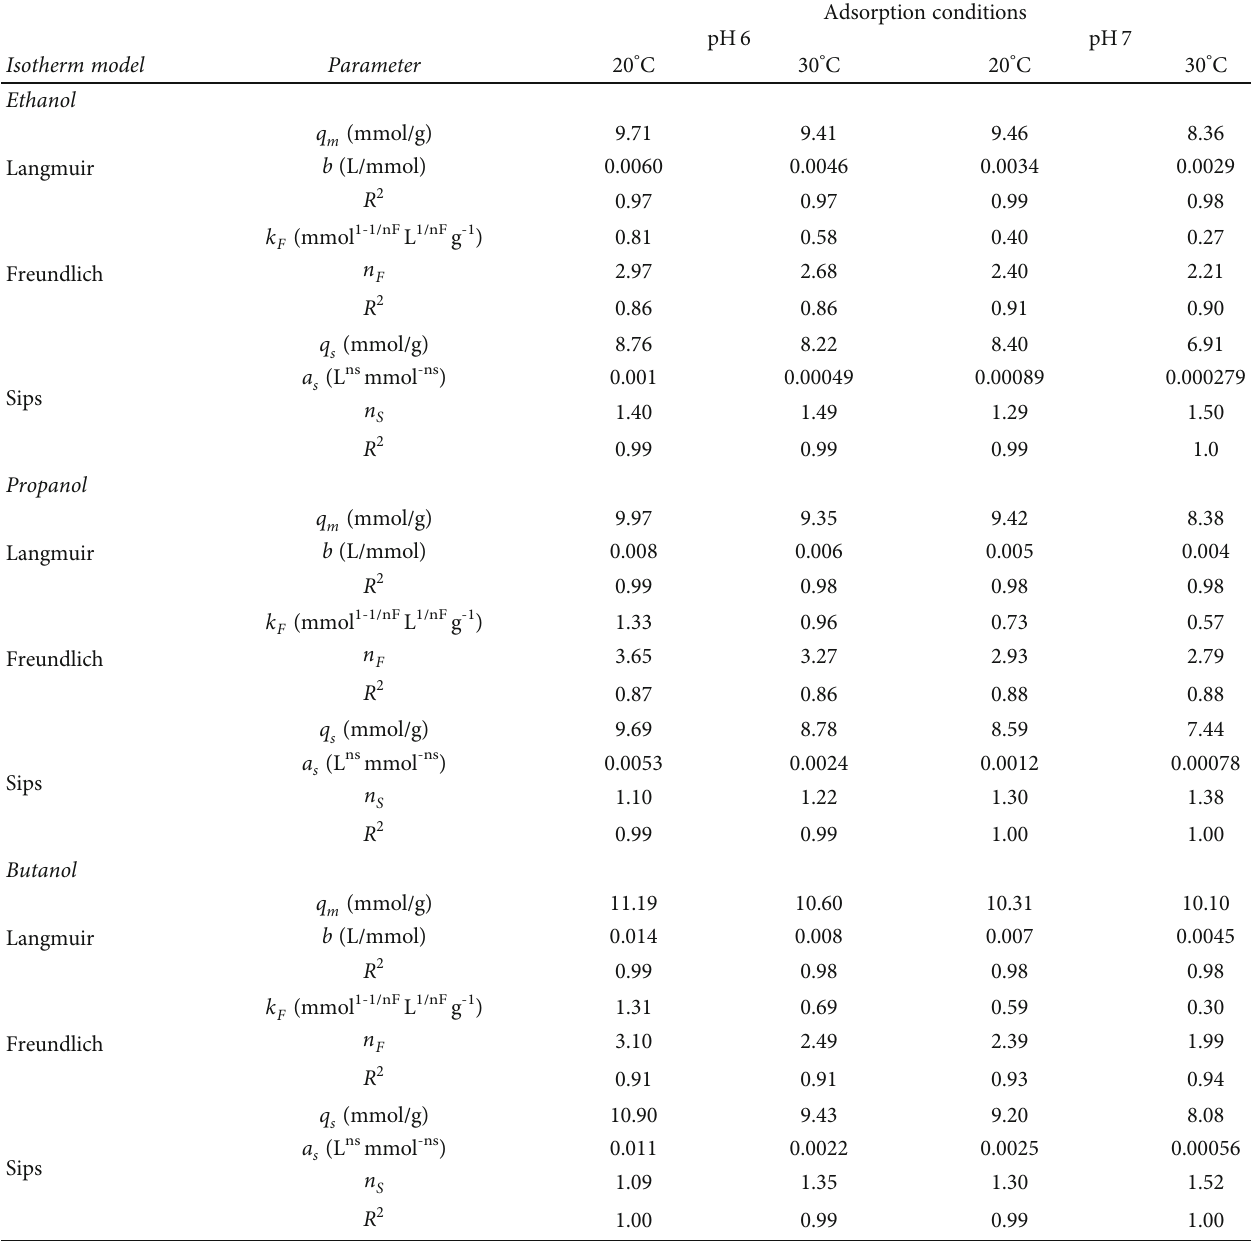
Table 4: Results of the equilibrium modeling of adsorption of ethanol, propanol, and butanol on bone